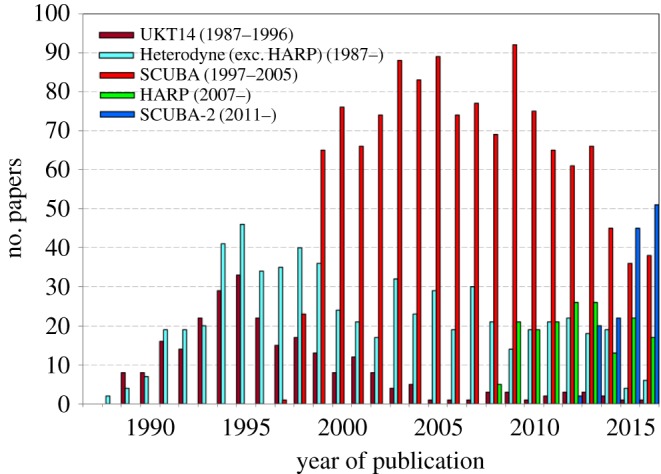
The number of peer-reviewed papers per year until the end of 2016 (information has been gathered from the SAO/NASA Astrophysics Data System). The dates in brackets refer to the operational period for the instrument (or range of instruments).